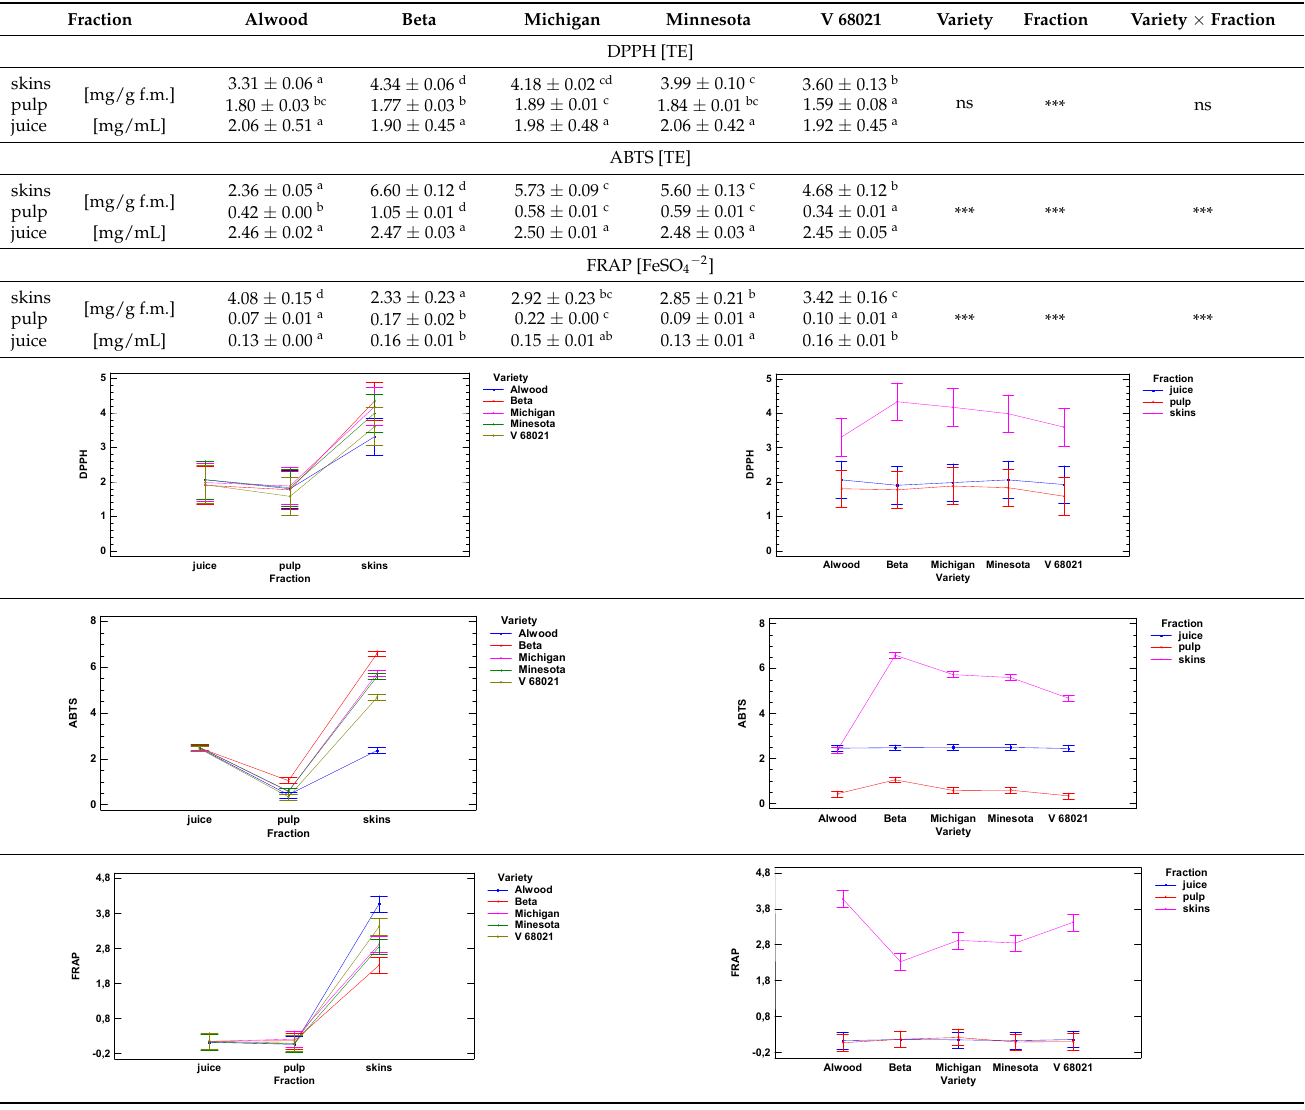
Lower-case letters mean values significantly different at p ≤ 0.05 in the rows. Asterisks represent the second order interactions analysis, ***—significantly different at p ≤ 0.001, ns—not significantly different, f.m.—fresh mass. TE—Trolox equivalent. Two-way ANOVA charts of factors (variety and fraction) interactions are given below for each assay type.